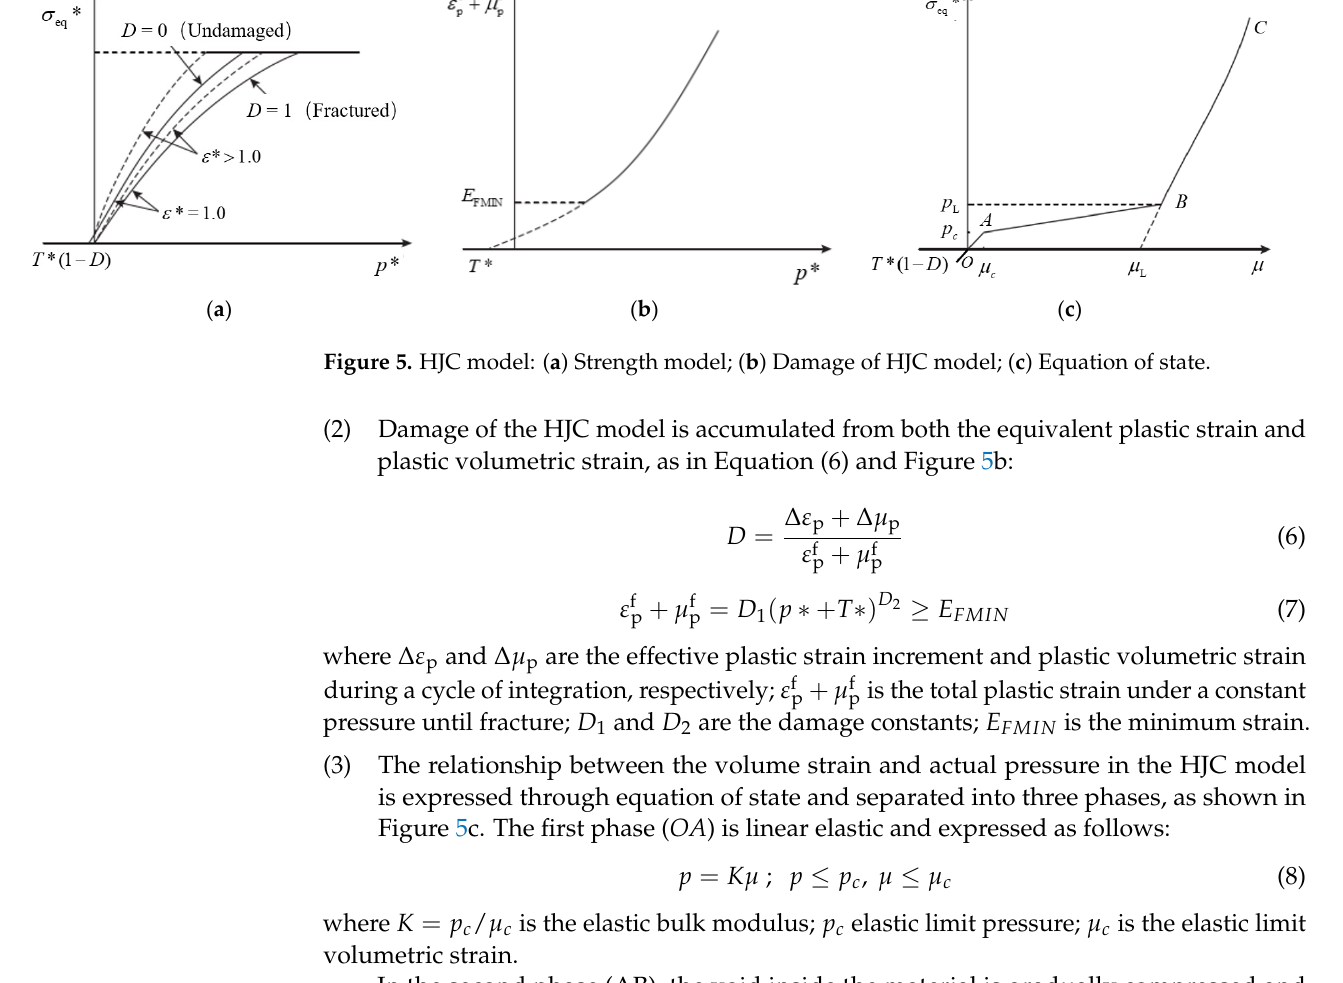
∗ = σ where σ / f c is the normalized equivalent stress; σ denotes the actual equivalent eq eq eq stress; S FMAX is the normalized maximum strength that the concrete material can withstand ≤ S ∗ = p / f and σ c is the FMAX ; f c is the unconfined uniaxial compressive strength; p eq . . dimensionless strain rate; is the normalized tensile strength, where T is the ε ∗ = ε / ε 0 is the dimensionless strain normalized pressure, where p is the actual pressure; rate; T ∗ = T / f c is the normalized tensile strength, where T is the unconfined uniaxial unconfined uniaxial tensile strength; A , B and N are material constants which represent tensile strength; A , B and N are material constants which represent the normalized cohesive the normalized cohesive strength, the normalized pressure hardening coefficient and the strength, the normalized pressure hardening coefficient and the pressure hardening expo- pressure hardening exponent, respectively; C is the strain rate coefficient; D (0 ≤ D ≤ 1) is nent, respectively; C is the strain rate coefficient; D (0 ≤ D ≤ 1) is the accumulated damage. the accumulated damage.